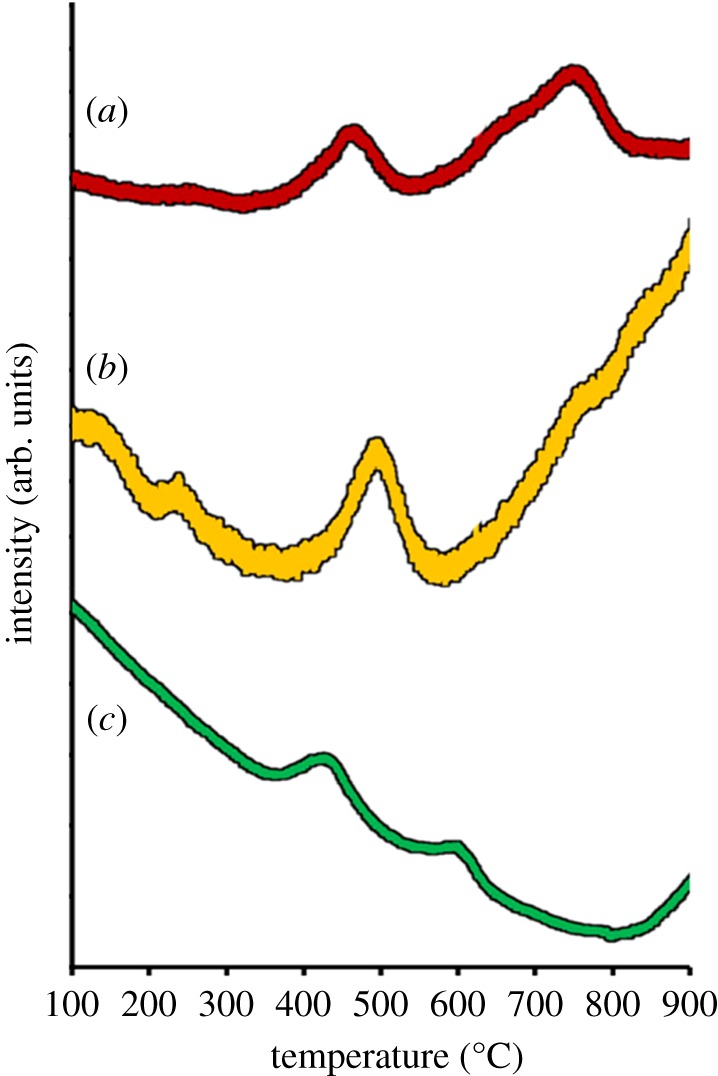
CO2-TPD profiles of (a) undoped ZnO, (b) 10% Ag/ZnO and (c) 10% Ni/ZnO nanomaterials.